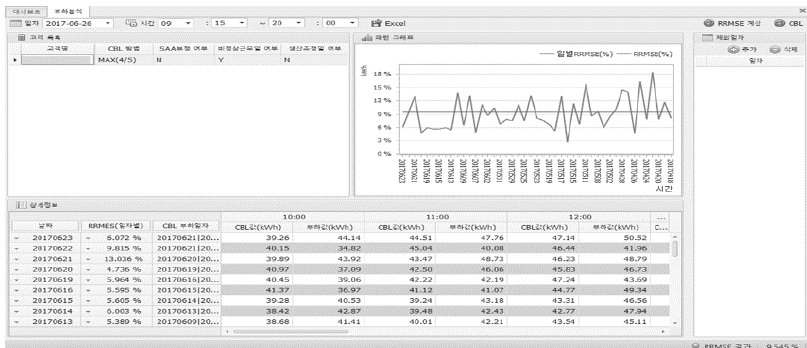
Figure 8. G store power RRMSE.